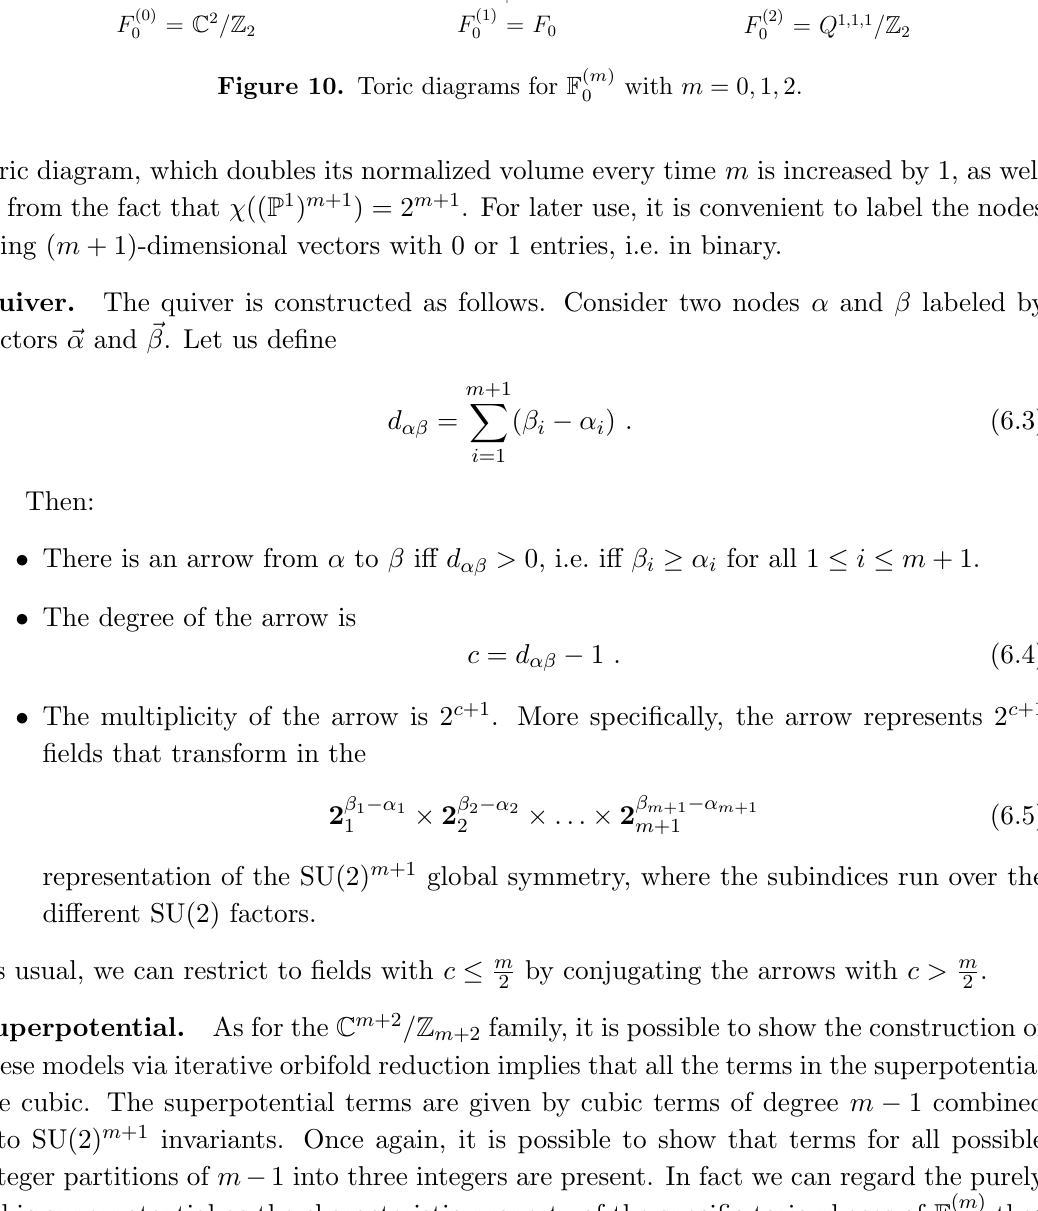
Figure 10. Toric diagrams for F ( m )